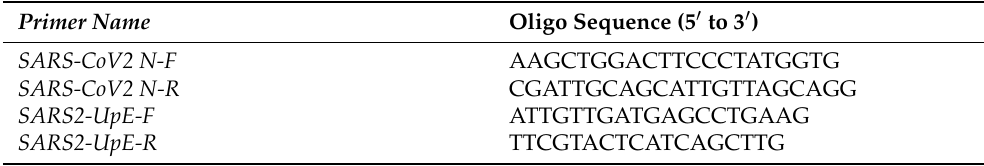
Table 2. Forward and reverse